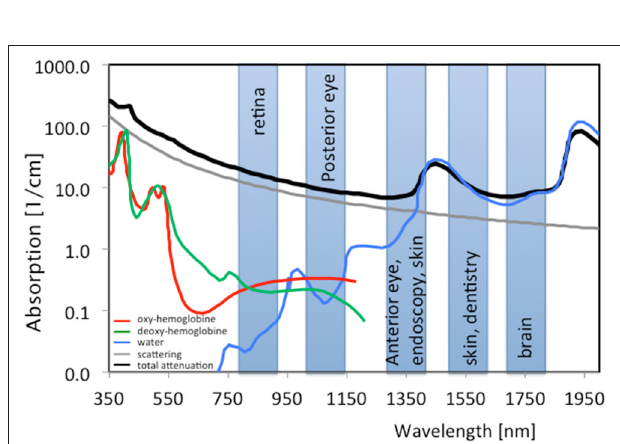
FIGURE 3 | Spectral absorption of water and tissue chromophores together with scattering; shaded boxes are typical center wavelengths used for OCT imaging with indicated applications; green, Hb; red; HbO 2 , blue, H 2 O; gray, scattering; black, typical tissue